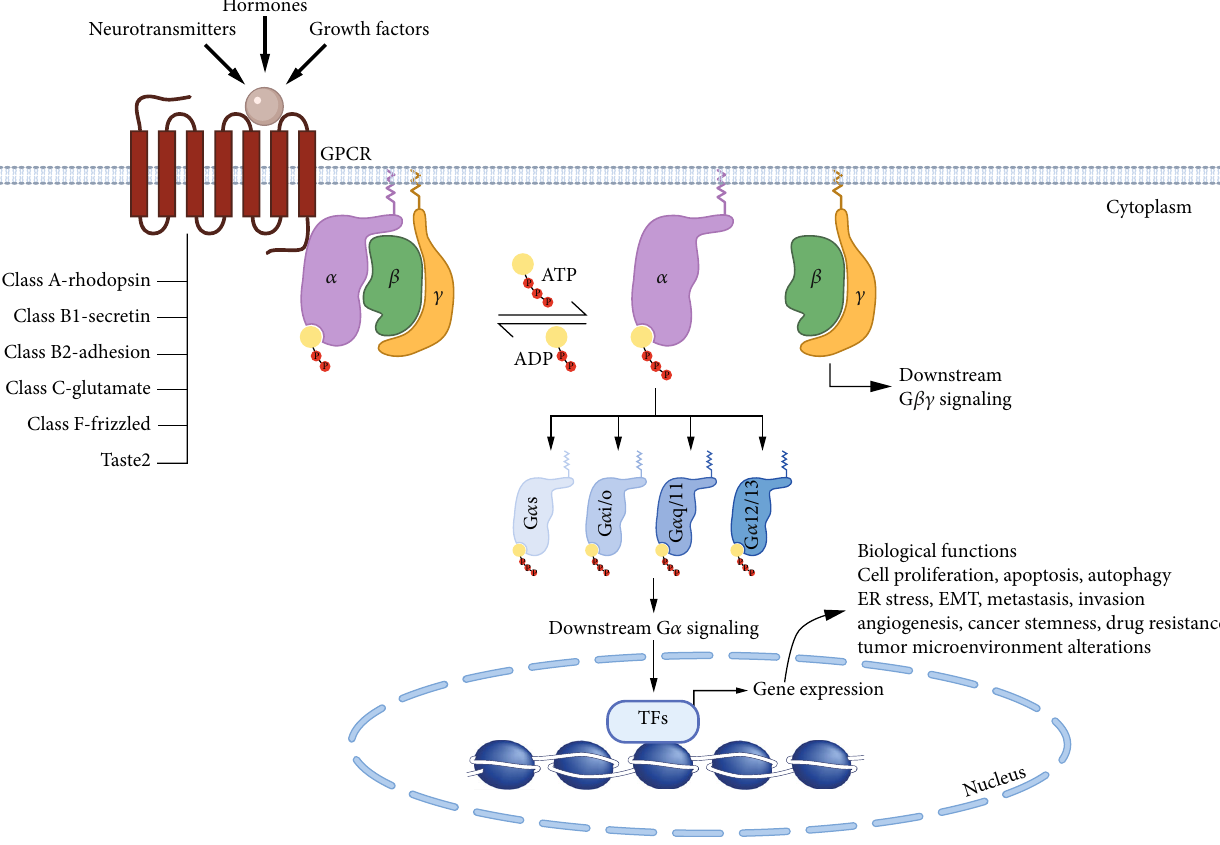
Figure 1: G protein-coupled receptor (GPCR) signaling pathway. Human GPCRs are seven-transmembrane receptor proteins divided into six classes (A, B1, B2, C, F, and Taste2). They receive signals from various stimuli (hormones, growth factors, neurotransmitters, etc.) and transduce the signal through G proteins in the cytosol. G proteins are made up of three subunits ( α , β , and γ ) and are anchored in the plasma membrane by binding through the α and γ subunits, while GPCRs bind G proteins through the α subunit. In the absence of stimuli, the G α subunit binds ADP and is inactive. However, upon activation, the α subunit binds ATP and dissociates from the β and γ subunits. There are four di ff erent types of G α subunits (G α s, G α i/o, G α q/11, and G α 12/13), which further relay the signal to downstream targets, ultimately leading to gene transcription. The dissociated G β -G γ dimer also participates in various downstream signaling pathways. In cancer, GPCR signaling is altered, leading to the activation of genes involved in cancer cell survival and